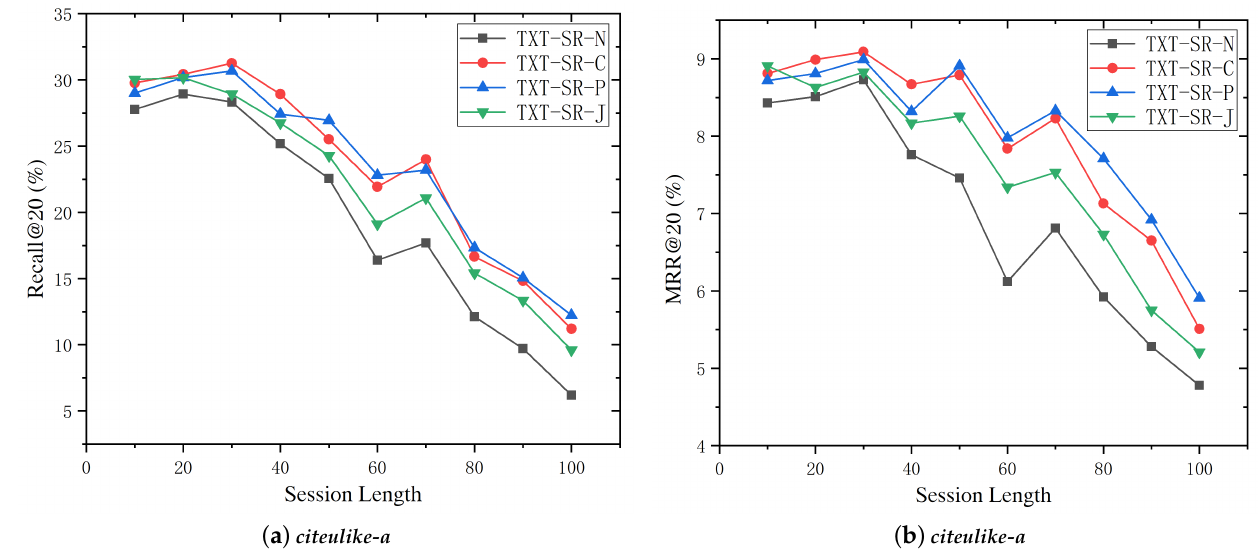
Figure 6. Performance comparison of different methods with different session lengths on citeulike-a .